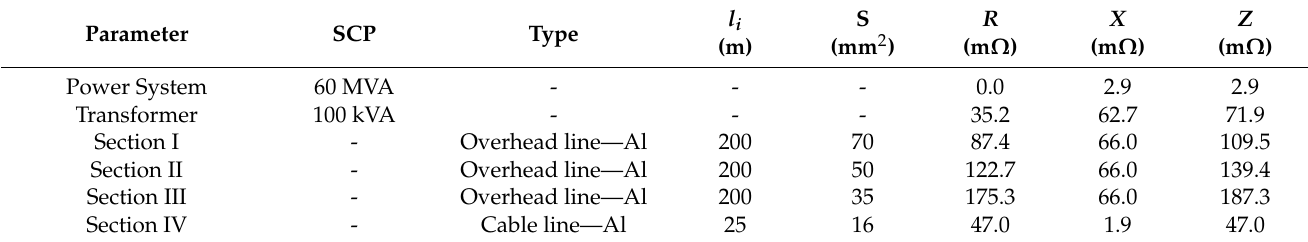
Table 3. Parameters of selected low-voltage power grid configurations with radial topology—Line 3.